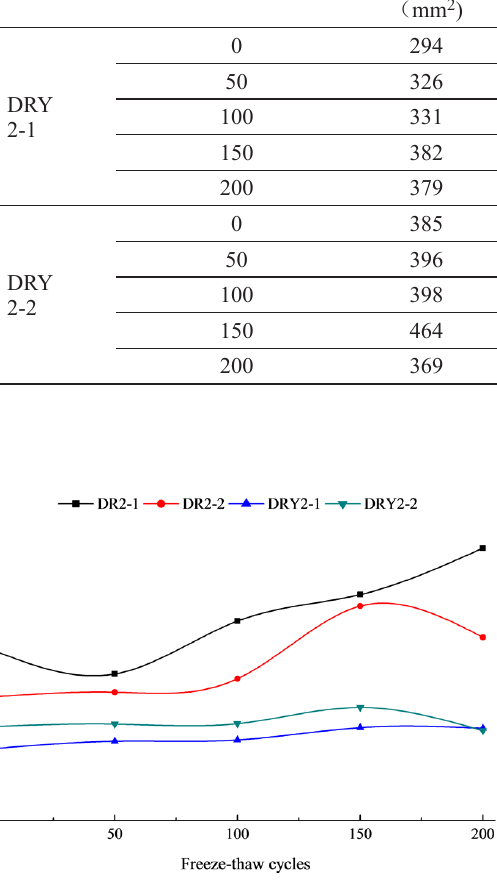
Fig. 14. Changes in the number of the pores (0.01 mm 2 to 0.50 mm 2 ) as the number of freeze-thaw cycles